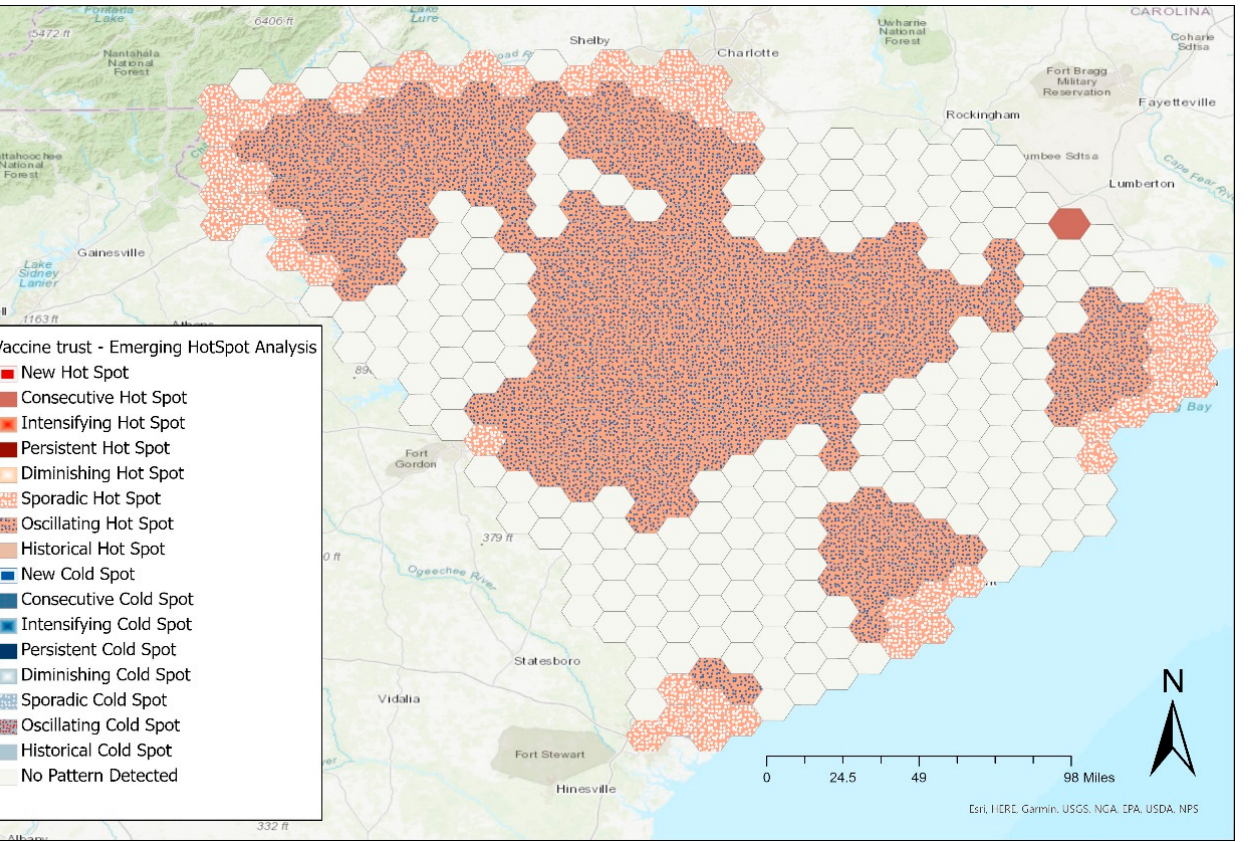
Figure 5. Emerging hotspot analysis of COVID-19 vaccination status among South Carolina residents, between January 2021 and October 2021.